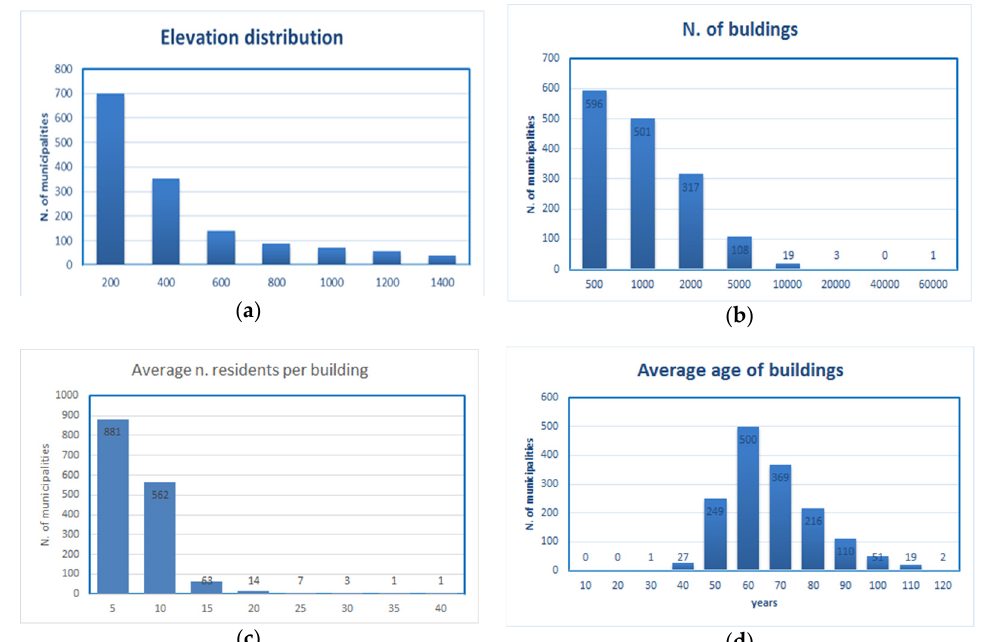
Figure 2. Lombardy’s municipalities characteristics: the histograms represent the distribution of the elevation of the urban centers ( a ); of the number of buildings ( b ), of the number of residents per building (a) proxy of the building size ( c ), and of the average building age ( d ).